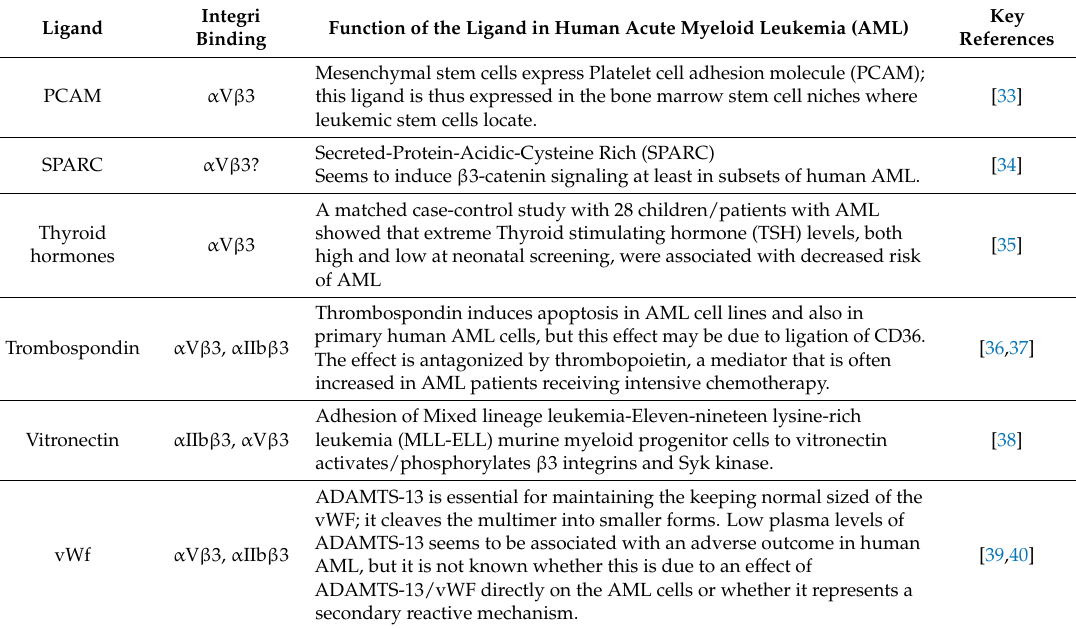
Table 1. Classification of β 3 integrin ligands and an overview of the importance ligands, their important functions and their integrin binding; for additional details see [9] and the Gene database [13–40].